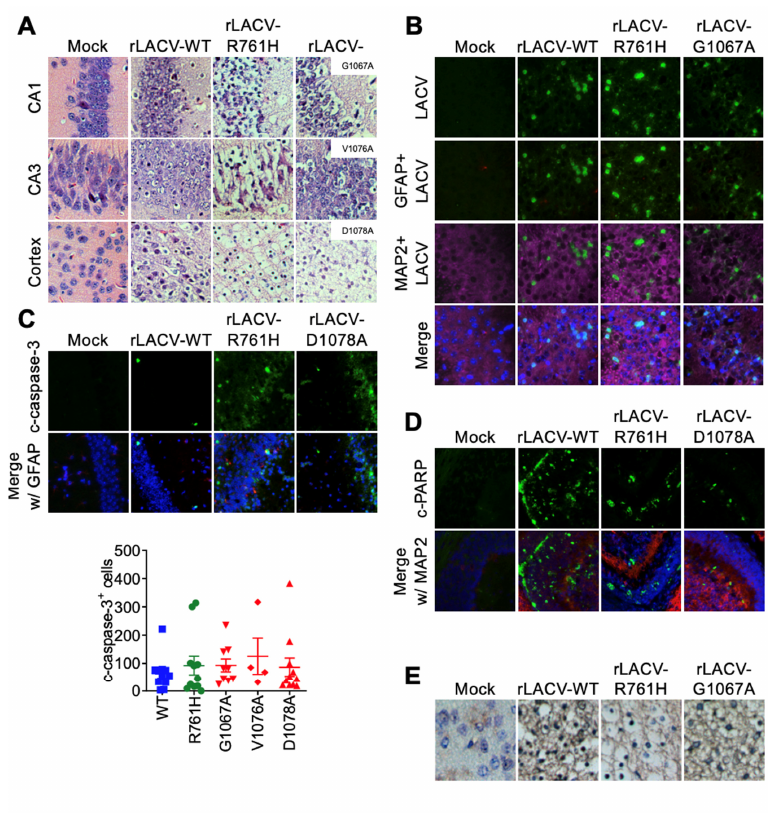
Figure 4. Histopathological changes and viral antigen in the brains of rLACV infected suckling mice challenged subcutaneously. ( A ) Hematoxylin and eosin staining showed widespread neuronal degeneration in the suckling mouse brains after rLACV infection. ( B ) Immunofluorescence of LACV antigen (Green) in the CA3 region of the hippocampus of moribund mice (GFAP = Red; MAP2 = Purple; Nuclei = Hoecht’s, blue). ( C ) Cleaved-caspase-3 (Green) and GFAP (Red) immunofluores- cence in the hippocampus of moribund mice. ( D ) Cleaved-PARP (Green) and MAP2 (Red) immu- nofluorescence in the cerebellum of moribund mice. ( E ) TUNEL-positive degenerating neurons (dark blue) and LACV antigen with hematoxylin counterstain.